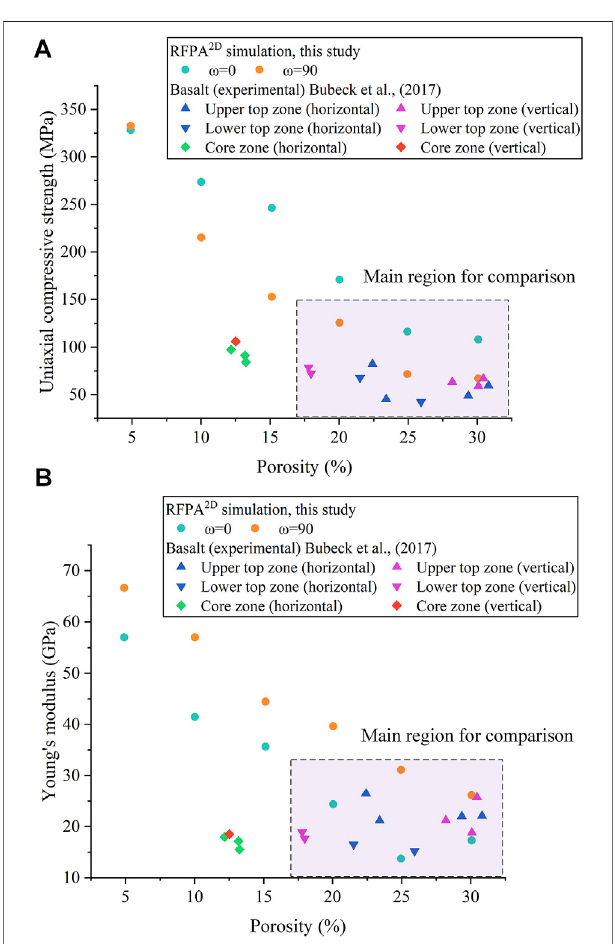
FIGURE 13 | Comparison between RFPA 2D simulation results with experimental data from Bubeck et al. (2017) of (A) strength and (B) Young ’ s modulus. The purple box highlights the main region for